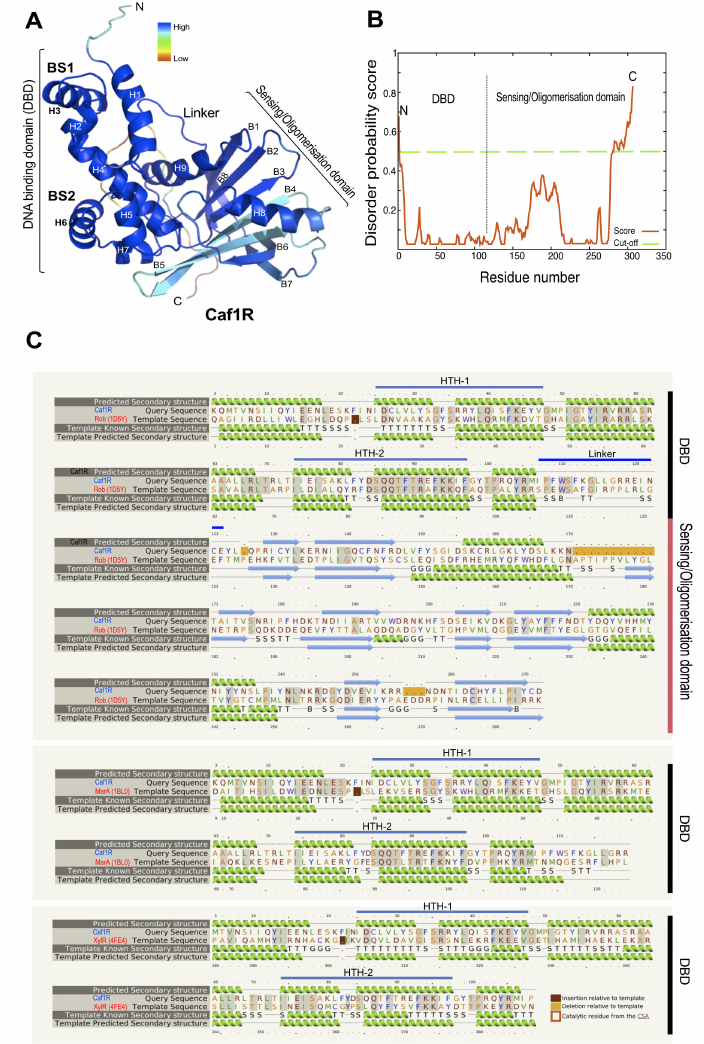
Figure 1. Caf1R modelled structure and its homology with E. coli Rob, MarA and XylR. ( A ) Int- FOLD3.0 [49] predicted model of the full-length Caf1R on Rob protein template (PDB 1D5Y). Quality of prediction is indicated by the β -factor colour intensity and its ≥ 70% non-redundancy, computed by IntFOLD3.0. Predicted DNA-binding domain (DBD) at the N-terminus composed of seven alpha helices (H1–H7), connected by an unstructured linker to the putative sensing/oligomerisation do- main at the C-terminus, comprised of H8–H9 and eight β -strands (B1–B8). ( B ) Disorder prediction plot (per residue) of the modelled structure, reinforces reliability of the Caf1R model. MacPyMOL1.3 was used to visualise and generate the ribbon diagrams of modelled Caf1R. ( C ) Phyre2 [50] predicted secondary structures alignment of the full-length native Caf1R (query) with the closest A/X family structural homologues, Rob (PDB 1D5Y), MarA (PDB 1BL0) and XylR (PDB 4FE4) as indicated. The helix-turn-helix (HTH) motifs of Caf1R-DBD, HTH-1 (H2–H3) and HTH-2 (H5–H6) are displayed with a thick blue line over respective helices. Amino acids highlighted in grey indicate aa identity of corresponding protein template with Caf1R: Rob (24%), MarA (34%) and XylR (35%). Seamless alignment of the Caf1R predicted secondary structures on the Rob template, confirms reliability of full-length Caf1R